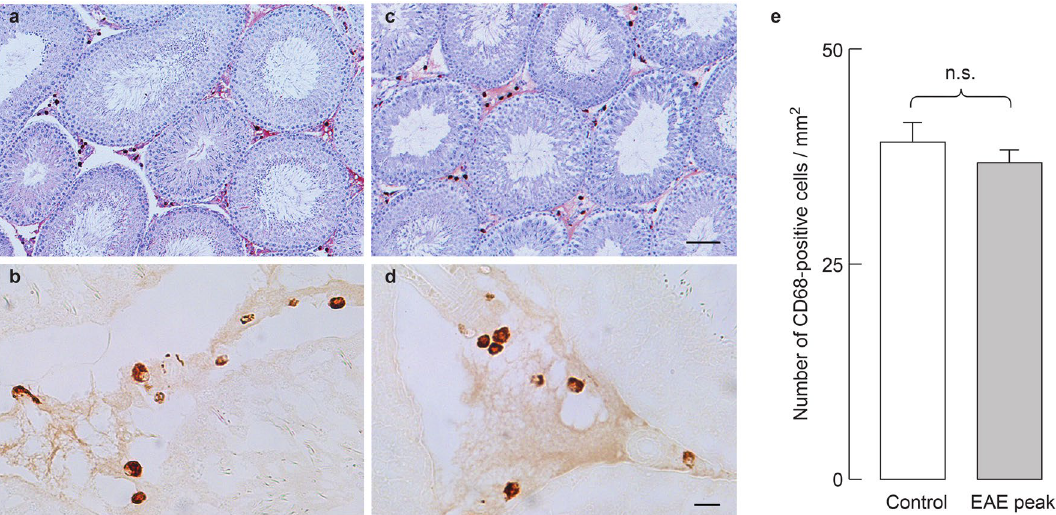
Figure 4. Immunohistochemical analysis of testicular macrophages in EAE. CD68 immunopositive cells were observed exclusively in the testicular interstitium of both control ( a , b ) and peak EAE ( c , d ) testes. Hematoxylin staining reveals normal histological structure of seminiferous tubules and interstitial space in both groups ( a , c ). Higher magnification images of the interstitium in CD68-stained sections depict macrophages in control ( b ) and peak EAE ( d ) animals. Quantification of CD68 staining ( e ) confirms that the number of macrophages does not change significantly in EAE (Mann–Whitney test). Data is plotted as mean ± SEM. Scale bar in ( c ) equals 100 μm and applies also to ( a ). Scale bar in ( d ) equals 20 μm and applies also to ( b ). The figure was made combining KaleidaGraph (version 4.1.0, http:// www. syner gy. com), Photochop CC (version 14.2, http:// www. adobe. com) and Illustrator (version 25.1.0, http:// www. adobe. com).